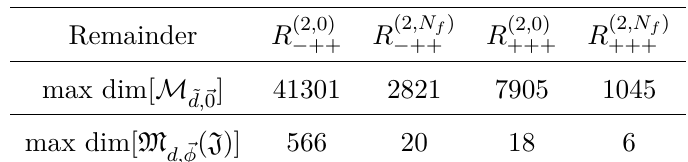
Table 4 . Summary of effect of algorithm on Ansatz dimension. The row labeled “max dim[ M ˜ d,~ corresponds to the largest Ansatz dimension for each basis function when using the little-group invariant techniques of ref. [17]. The ˜ d correspond to third column of table 1. The row labeled “max dim[ M d,~φ ( J )] ” gives the largest Ansatz dimension for each amplitude when the codimension-two scaling constraints are taken into